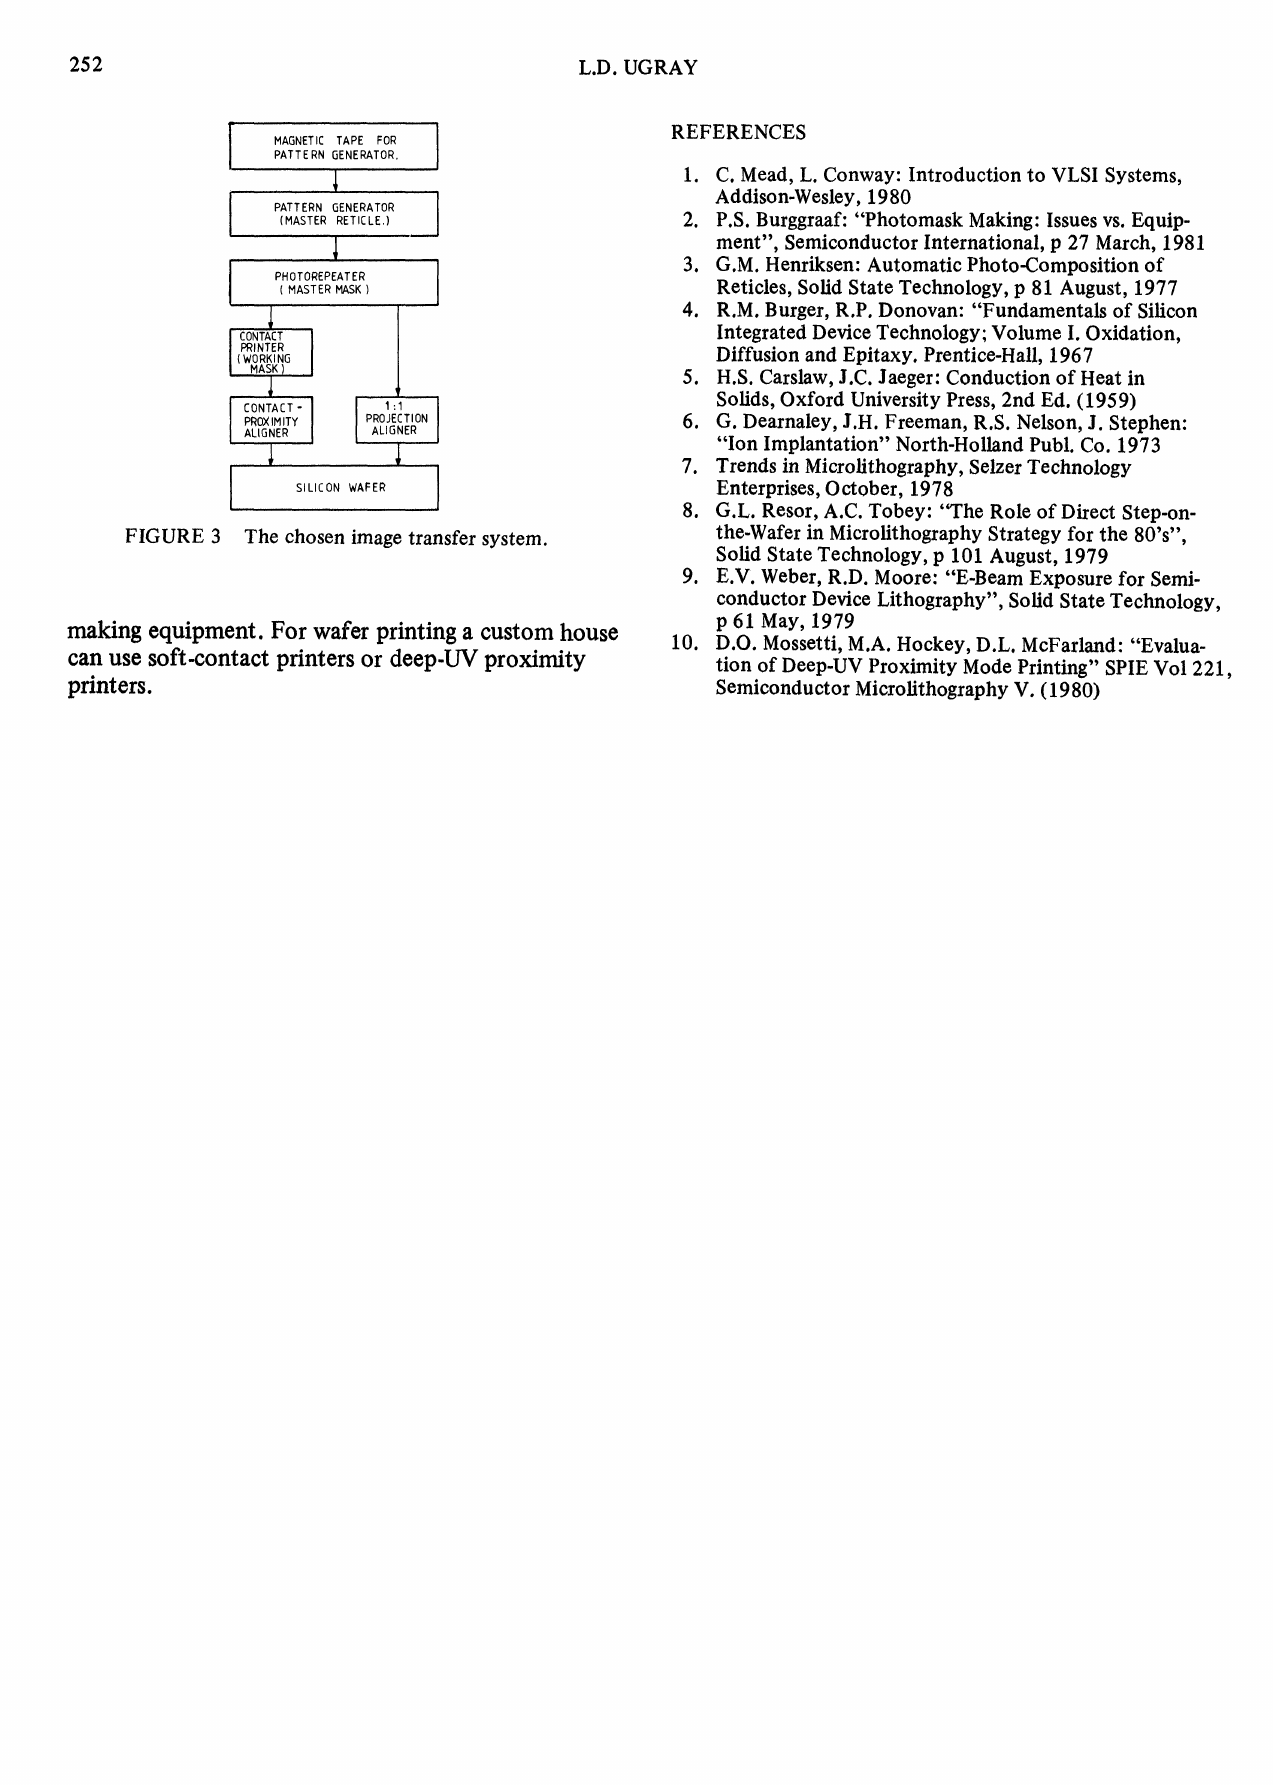
MASNETIC TAPE FOR PATTE RN IENERATOR,